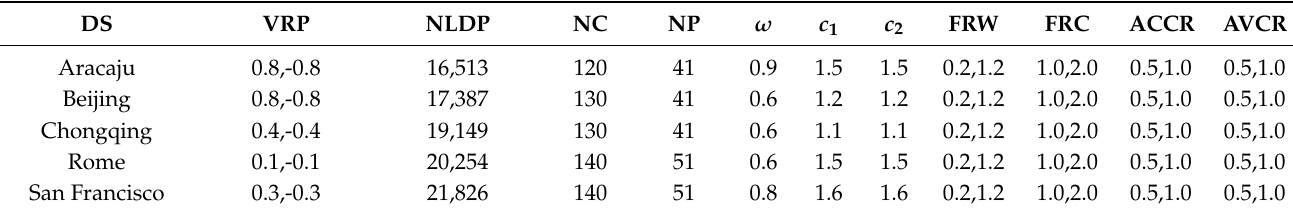
Table 4. PSO and fuzzy system parameter